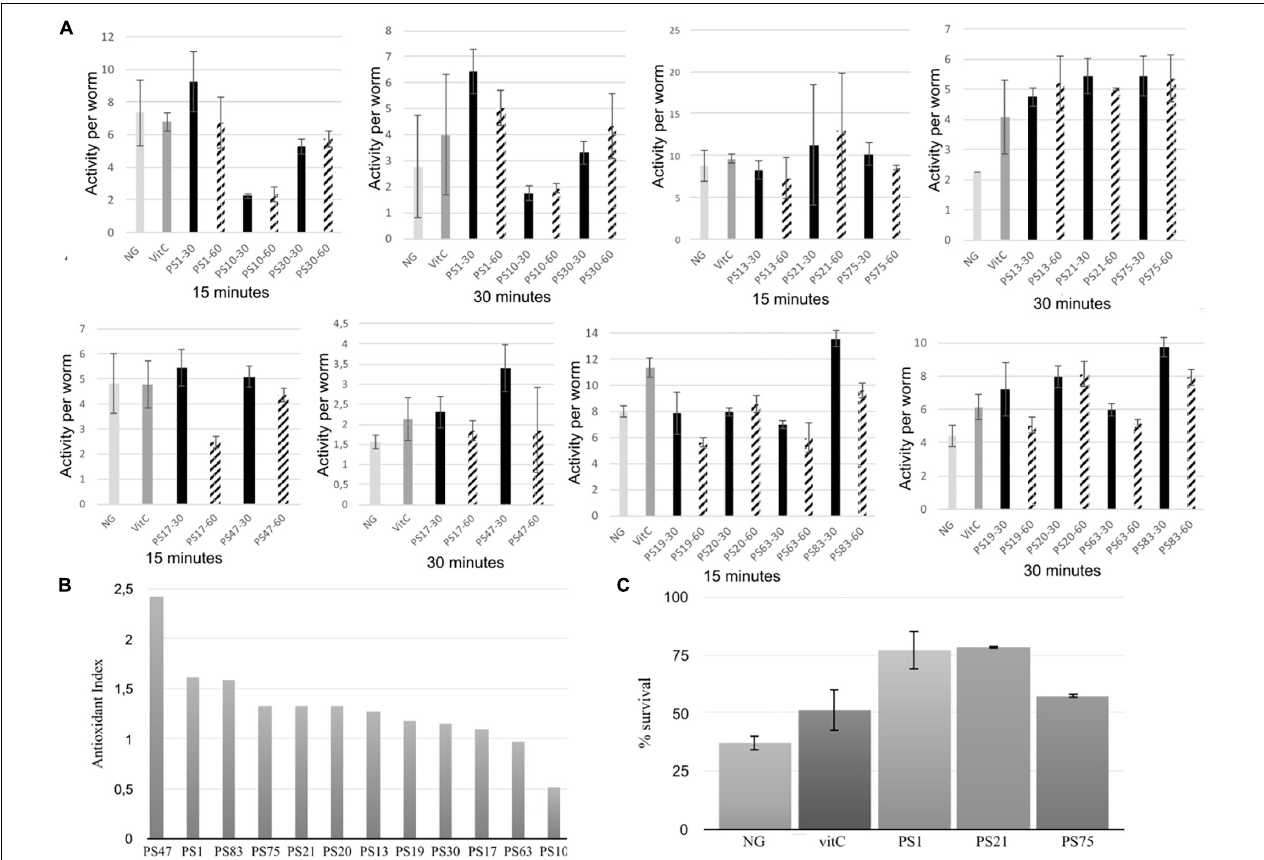
FIGURE 1 | (A) Oxidative stress assays of the selected isolates using the WT device. Worms were fed with the selected isolates at either an OD 600 of 30 or 60. Survival rate is represented in the Y-axis in the form of activity per worm, and results are shown after 15 and 30 min of incubation with hydrogen peroxide. Error bars indicate standard deviation. (B) Antioxidant index (AI) of the pigmented bacterial isolates from solar panels. AI was calculated by dividing the highest activity average (at an OD 600 of 30 or 60) of each isolate by the average activity of the positive control (vitC) after 30 min of incubation with hydrogen peroxide. (C) Manual oxidative stress assay results. Y-axis indicates percentage of survival of the worms after 5 h of incubation in nematode growth medium supplemented with 20 mM hydrogen peroxide. NG (Nematode growth), negative control. VitC (vitamin C), positive control. Error bars indicate standard